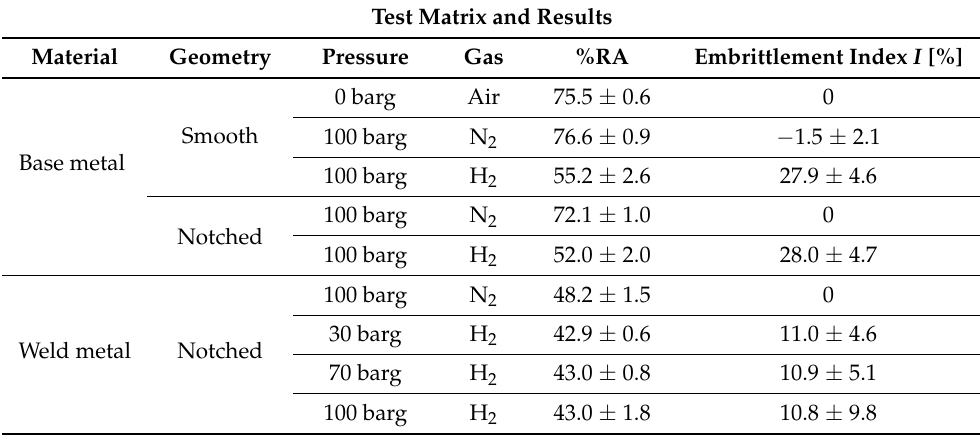
Table 3. %RA and embrittlement index I values for all sample sets. Errors are standard deviation.